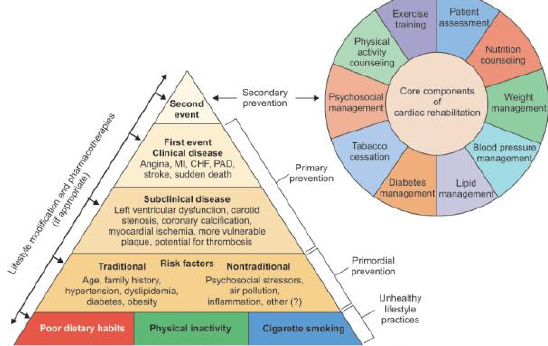
Figure 1. Core components of cardiac rehabilitation. (5) MI, myocardial infraction; CHF, congestive heart failure; PAD, peripheral arterial